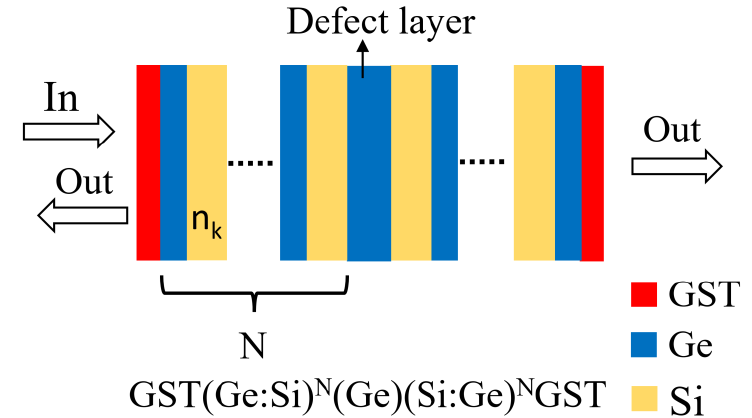
Figure 3. Schematic diagram of the photonic synaptic layer structure.